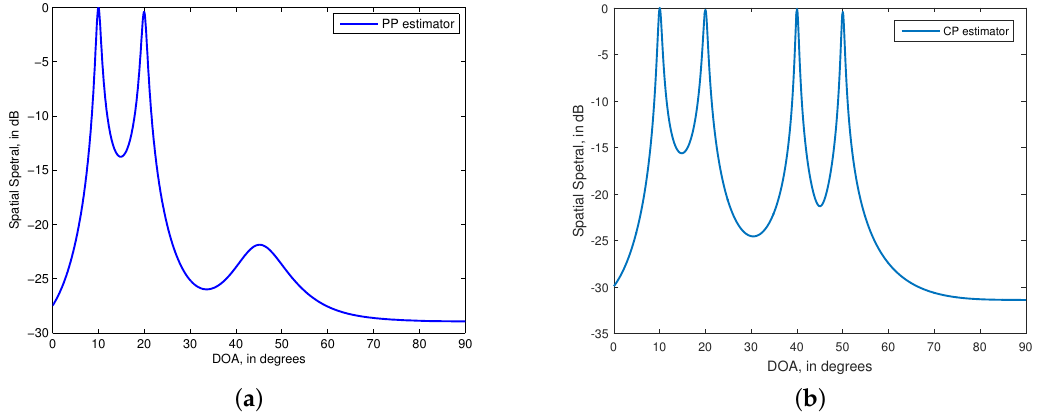
Figure 2. MUltiple SIgnal Classification (MUSIC) spatial spectral of the estimators. ( a ) partially polarized (PP) estimator for estimating two PP signals with { θ 1 , θ 2 } = { 10 ◦ , 20 ◦ } ; ( b ) completely polarized (CP) estimator for estimating two CP signals with { θ 3 , φ 4 } = { 40 ◦ , 60 ◦ } . SNR = 10 dB, N = 200. 500 independent